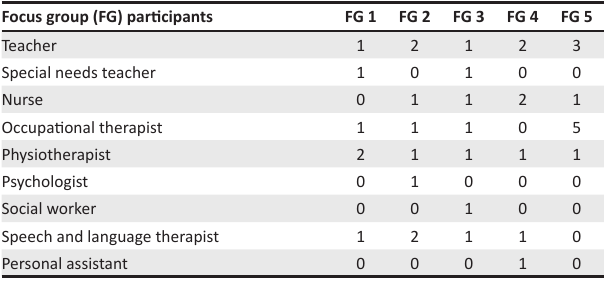
TABLE 3: Background information of the focus group participants at each school.